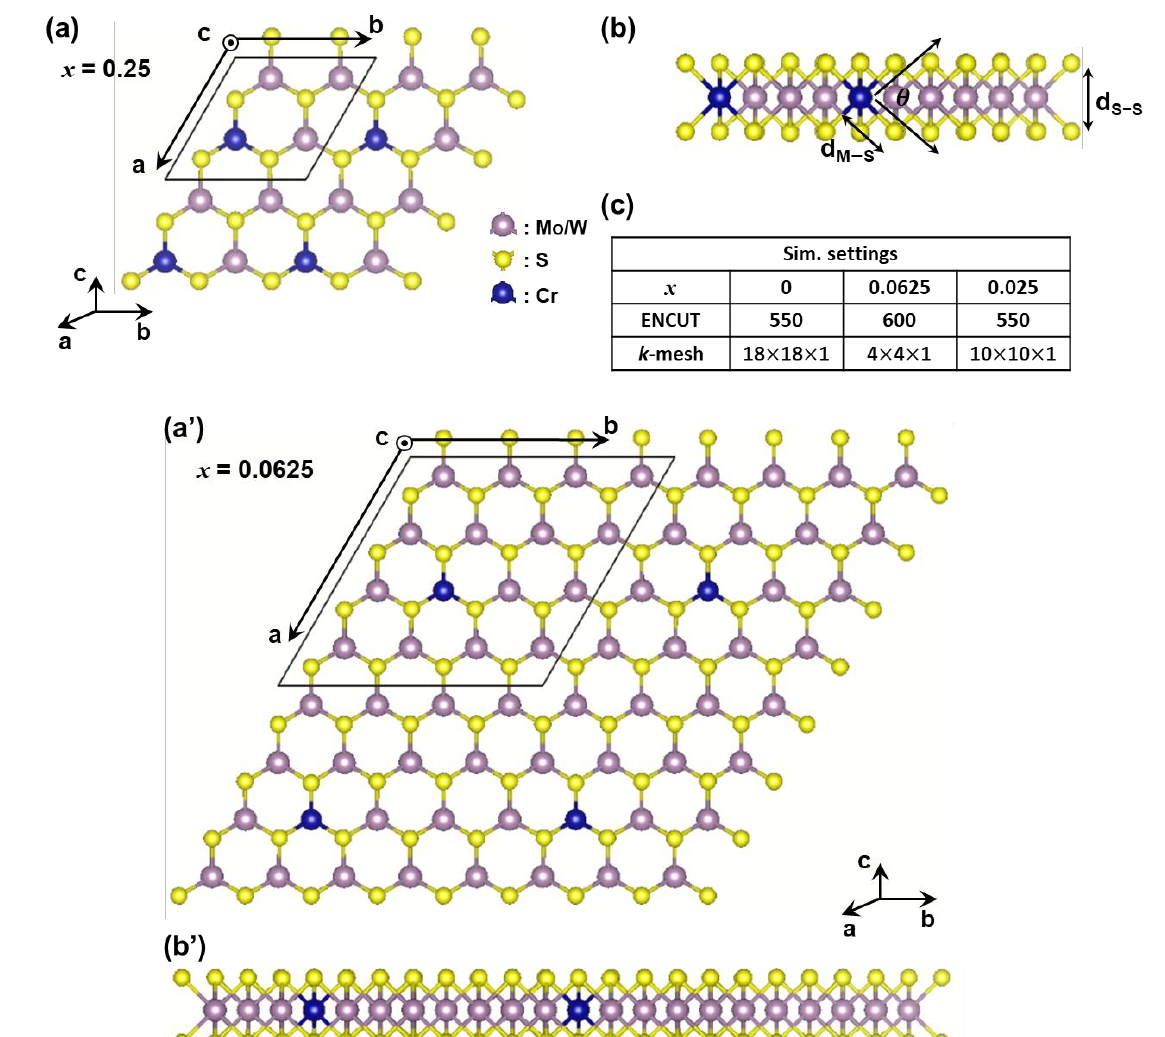
Figure 1. Top view and side view of monolayer M 1− x Cr x S 2 (M = Mo, W) with different compositions: ( a – b ) x = 0. 25 and ( a ’– b ’) x = 0.0625. For x = 0. 25 and 0.0625, one of the Mo or W atoms was replaced by one Cr atom in a MoS 2 or WS 2 supercell monolayer, with sizes of 2 × 2 and 4 × 4, respectively. Notably, d S − S is the material thickness. ( c ) The critical simulation settings for different mole